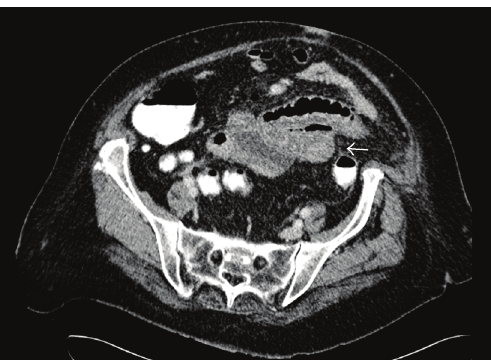
Figure 1: Discrete inflammatory changes in the mesogastric fatty tissue surrounding several jejunal loops. An air containing mass suggestive of a diverticulum can be seen (arrow).